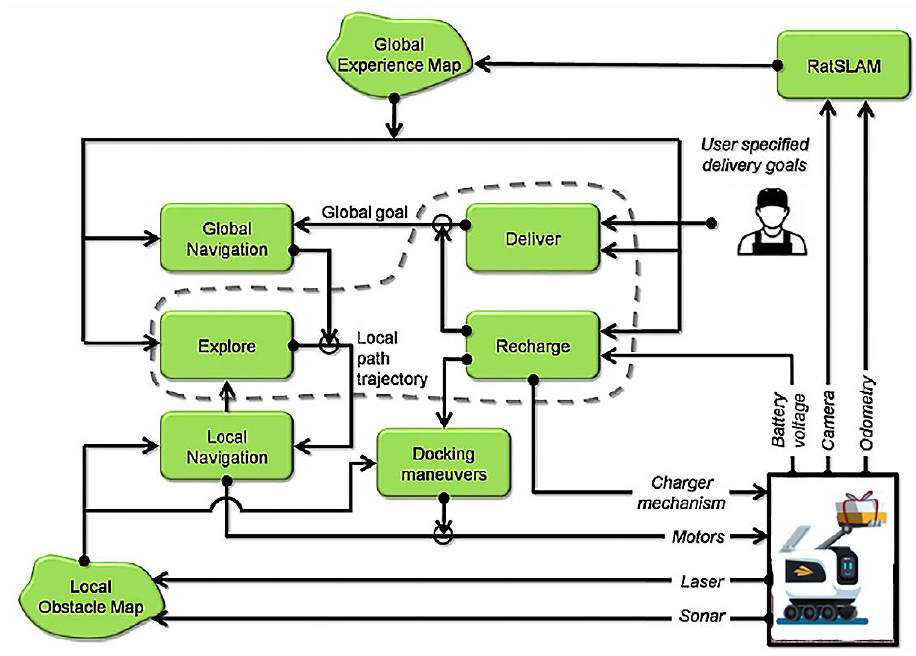
Figure 2. The composition of the control center system.